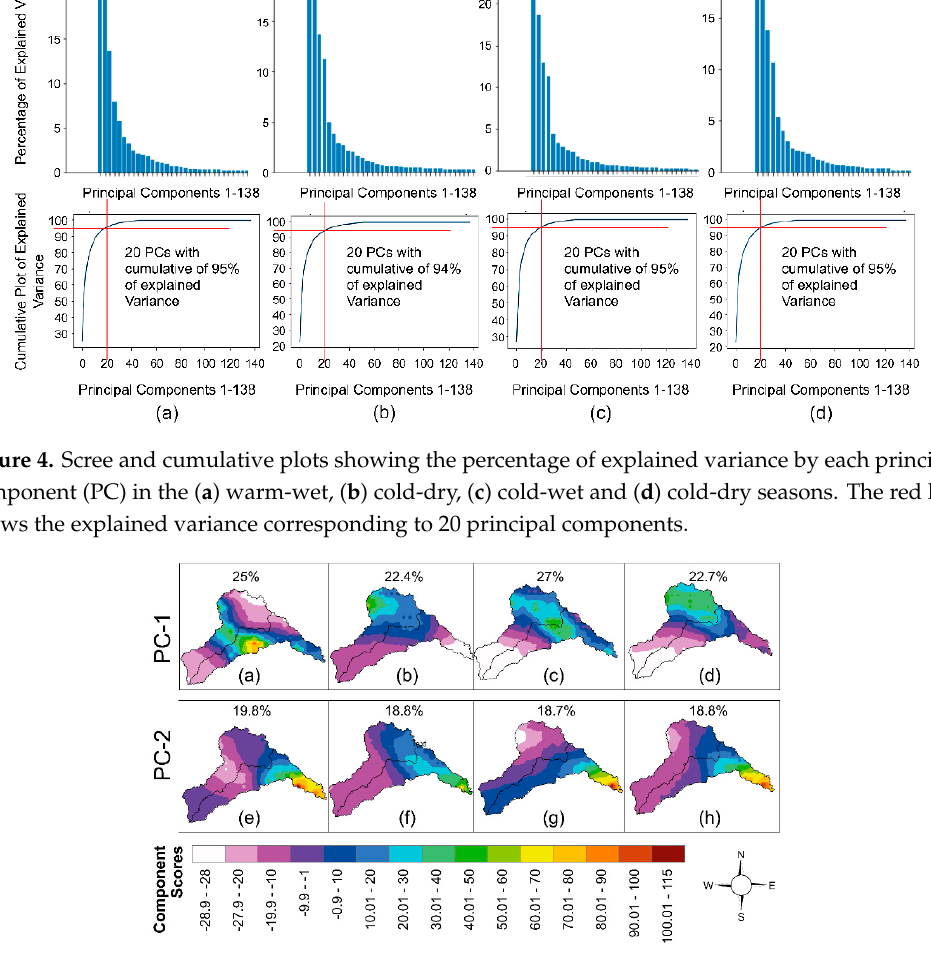
Figure 5. The spatial patterns of the first two PCs for the daily seasonal precipitation across the study area. The explained variance % is presented on each panel. The component scores are presented by the color distributions across the study area (see color bar for reference): ( a ) warm-wet (PC-1), ( b ) cold-dry (PC-1), ( c ) cold-wet (PC-1), ( d ) warm-dry (PC-1), ( e ) warm-wet (PC-2), ( f ) cold-dry (PC-2), ( g ) cold-wet (PC-2) and ( h ) warm-dry (PC-2) seasons.